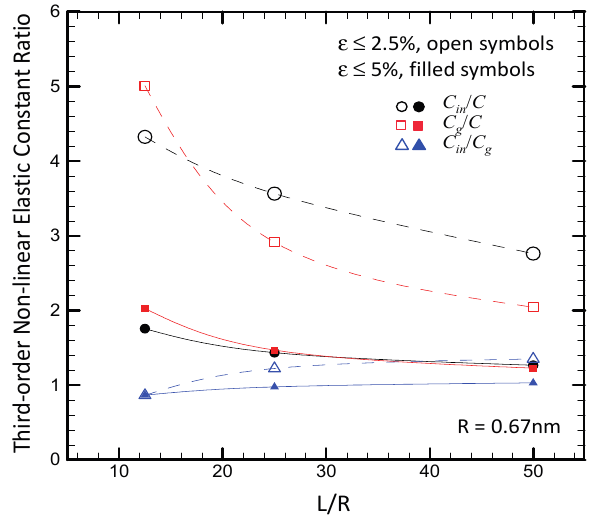
Figure 11. Relationship between the third-order elastic constant ratio of graphene ( C and the ratio of graphene length to the indenter tip radius, L/R . C constant determined from in-plane tension.